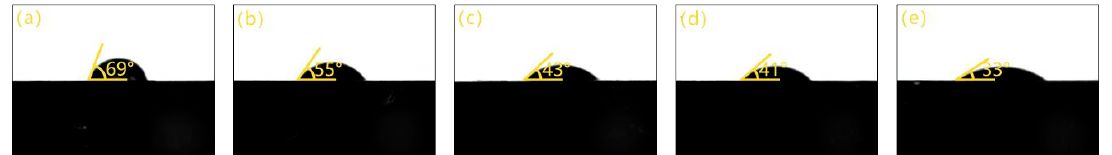
Figure 11. The contact angle of ( a ) original sample and sample soaked by different drilling fluids ( b )